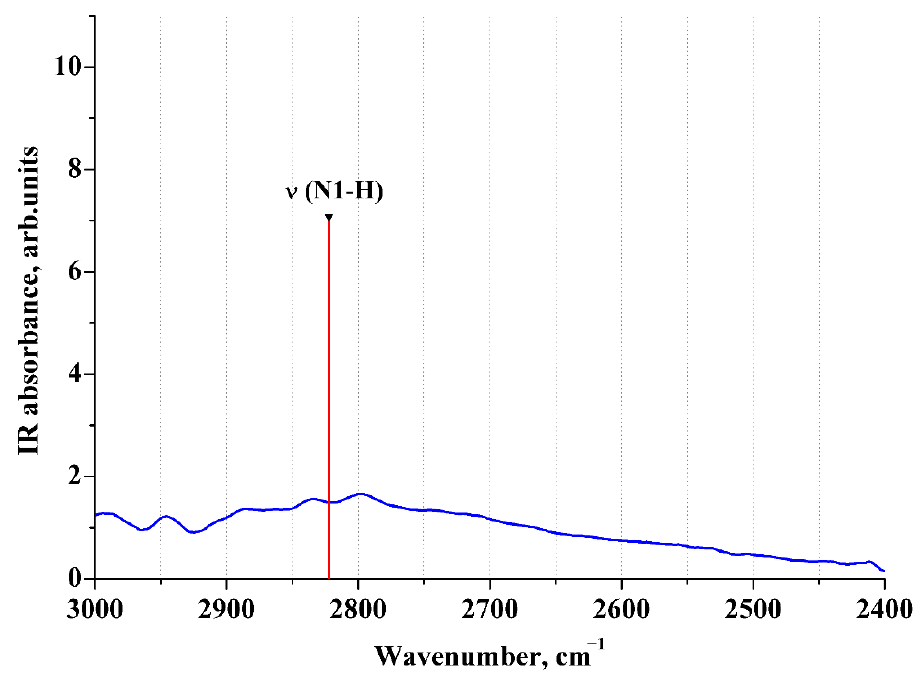
Figure 9. Experimental ATR IR spectra of aqueous solution of [2AmPyr + Mle] in the range of 3000–2400 cm − 1 . The computed N1–H stretching vibration is given by a stick. Its height is proportional to the theoretical IR intensity.